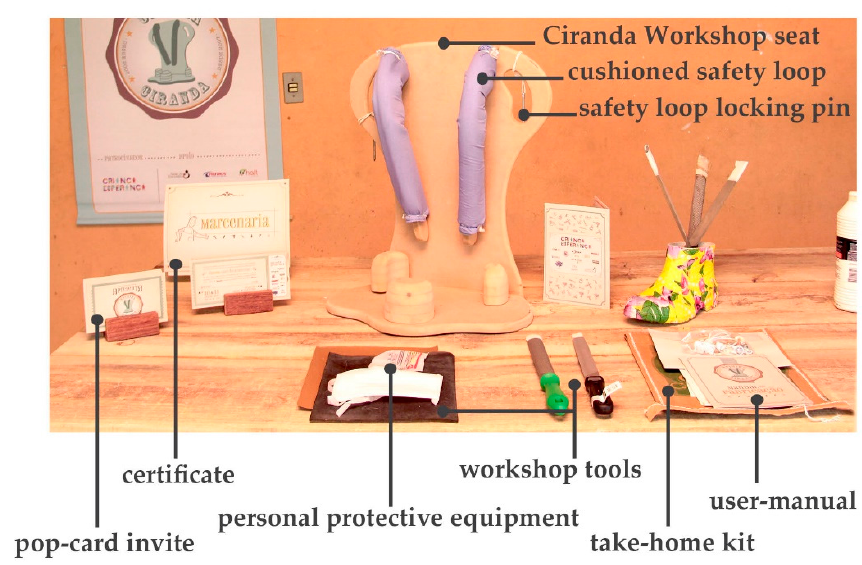
Figure 3. Ciranda Workshop concluded seat and the items used to reproduce the seat.